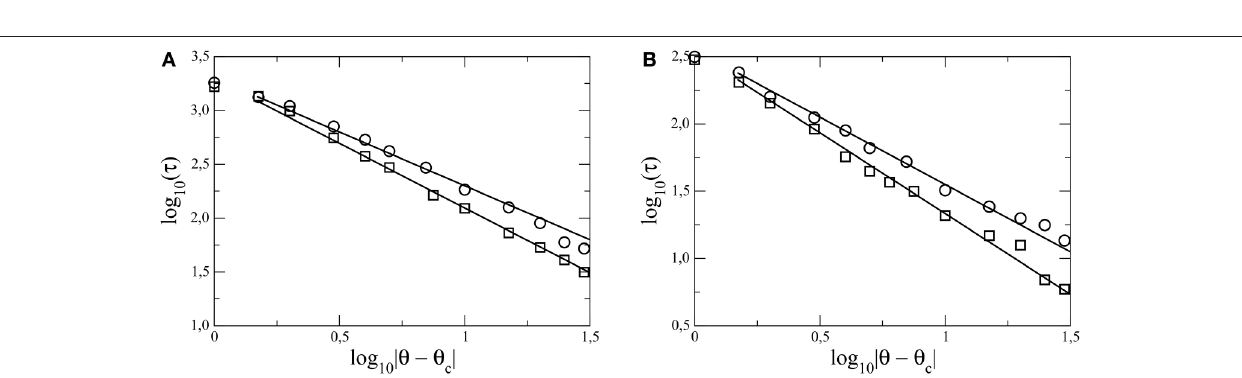
FIGURE 9 | Plot of log τ vs. log | θ − θ c | , where θ is the final allowed wetting angle in any pore, θ c = 90 ◦ and τ is steady-state initialization time (measured in pore-volumes) after wettability alteration is initiated. For (A) the capillary number Ca = 10 − 1 with oil saturation S = 0.3 and for (B) Ca = 10 − 2 with S = 0.4 . From the slopes, the value of the dynamic critical exponent α is obtained as α = 1.0 ± 0.1 for θ < θ c (circles) and α = 1.2 ± 0.1 for θ > θ c (squares).